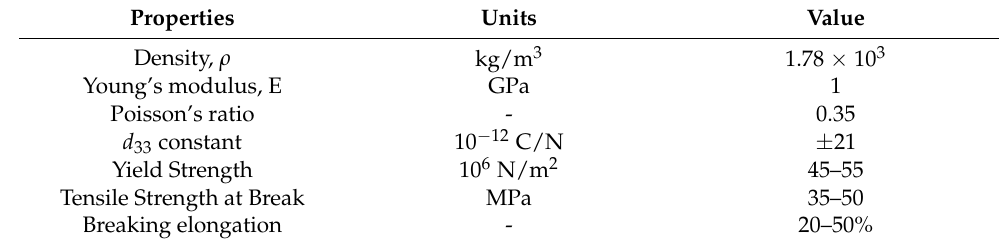
Table 1. Material properties of the polyvinylidene fluoride (PVDF) piezoelectric thin film.